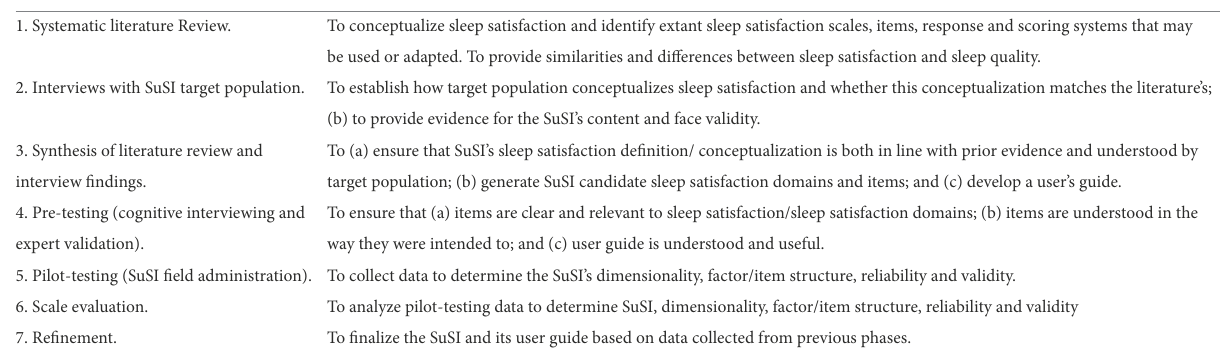
TABLE 1 Overview of seven-phase SuSI development process. Phase